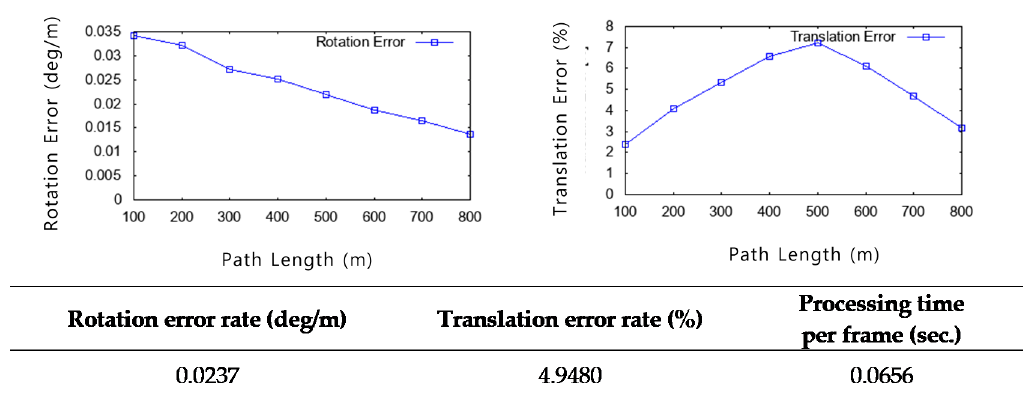
Figure 20. Graph of error over mileage for sequence 06.